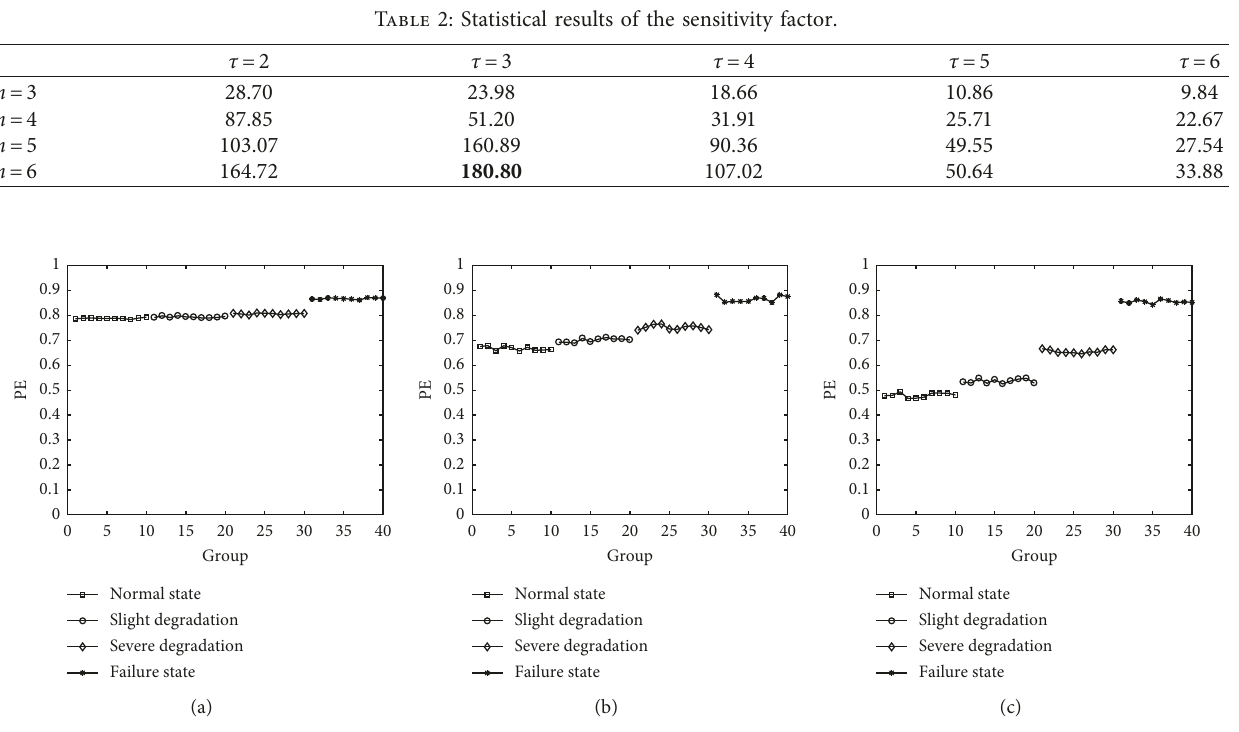
103.07; (c) m (cid:31)